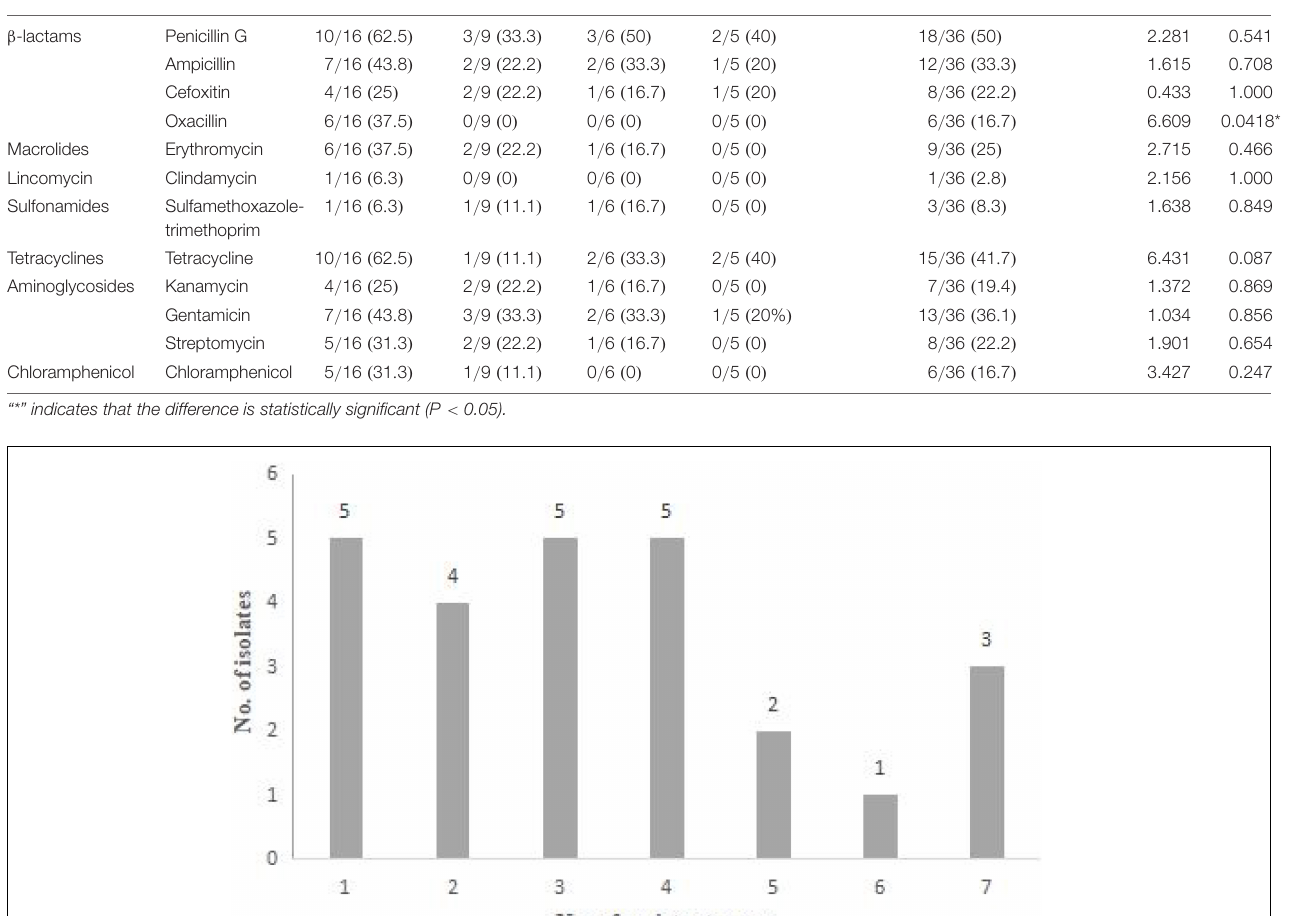
by buffalo milks (6/36, 16.7%), camel milks (4/36, 11.1%), and yak milks (3/36,